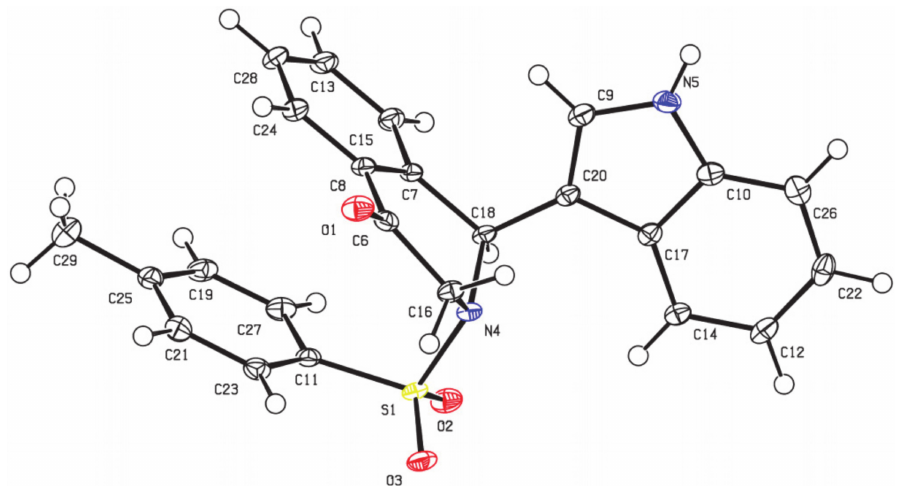
Figure 3. X-ray structure of